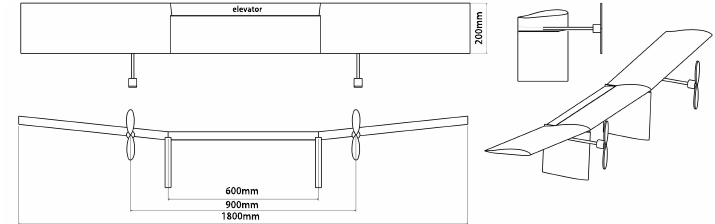
Figure 4. The three-view and isometric drawings of the high aspect ratio full-wing drone.